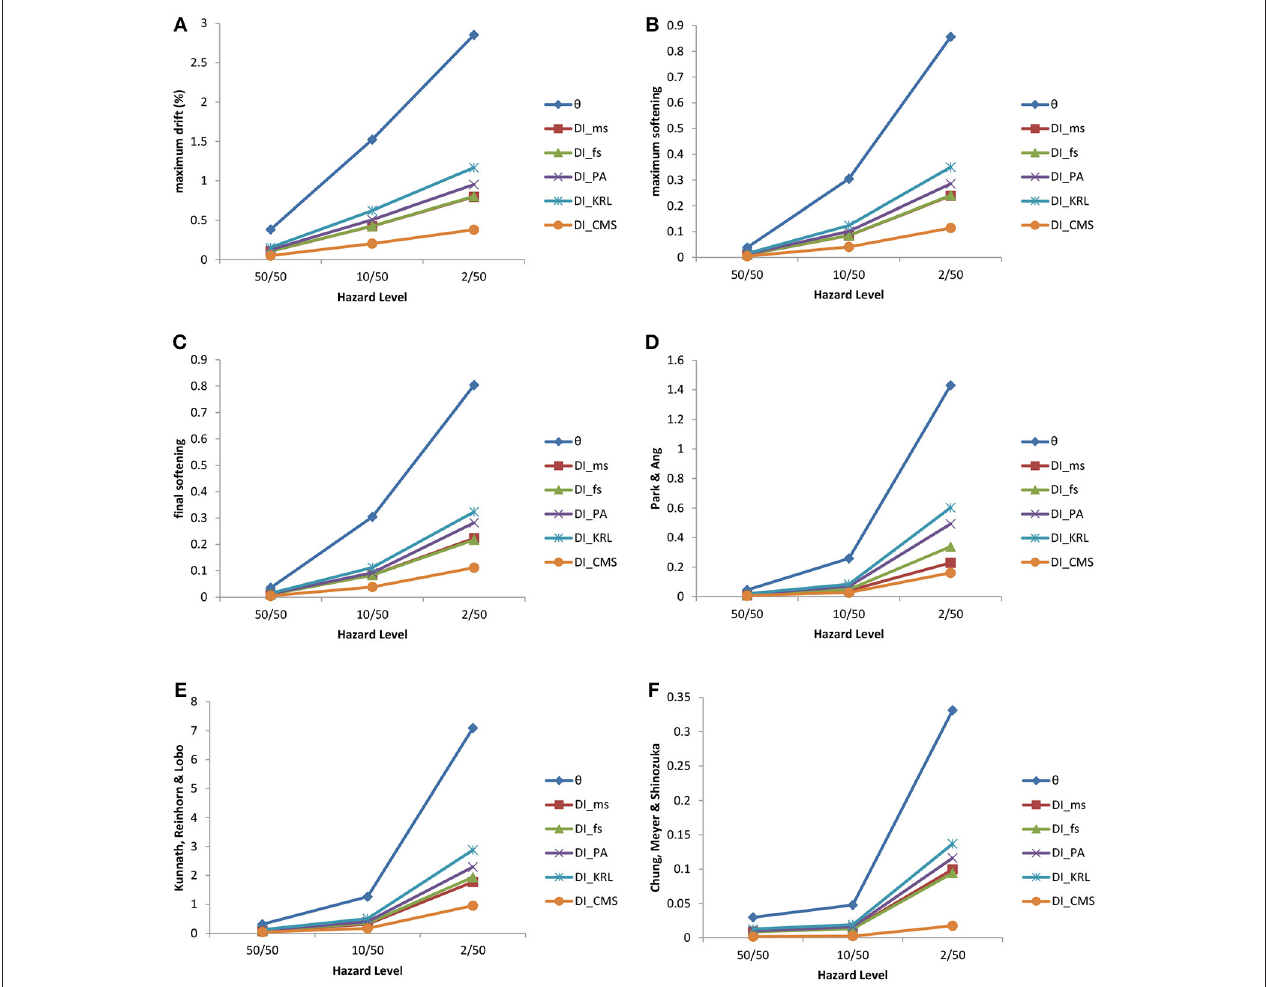
FIGURE 6 | Six-story test example—performances of the optimized designs (i.e., DI θ max , DI ms , DI fs , DI PA , DI KRL , and DI CMS ) for three hazard levels compared with respect (A) maximum drift, (B) maximum softening, (C) final softening, (D) Park and Ang damage index, (E) Kunnath et al. damage index, and (F) Chung et al. damage